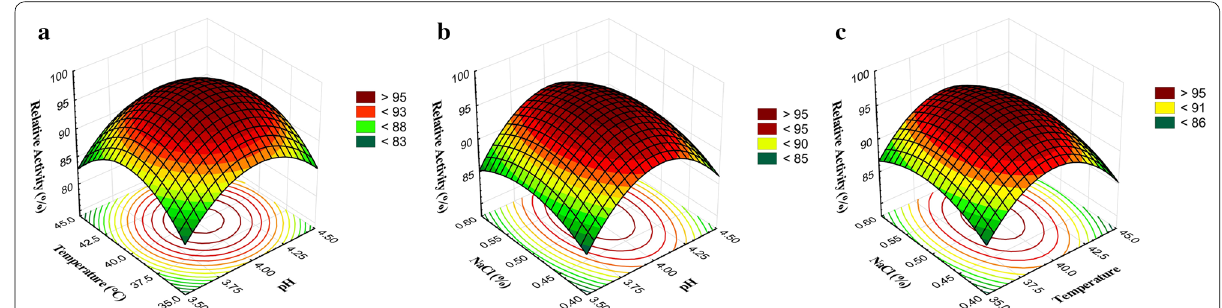
Fig. 3 Response surface plot for the β-glucosidase activity during fermentation the interaction of independent variables namely, pH, temperature, and NaCl concentration on β-glucosidase activity during fermentation. The values were represented as relative activity (%). a Effect of temperature and pH on enzyme activity of S. cerevisiae , b effect of NaCl concentration (%) and pH on enzyme activity of S. cerevisiae , and c effect of NaCl concen- tration (%) and temperature on enzyme activity of S. cerevisiae